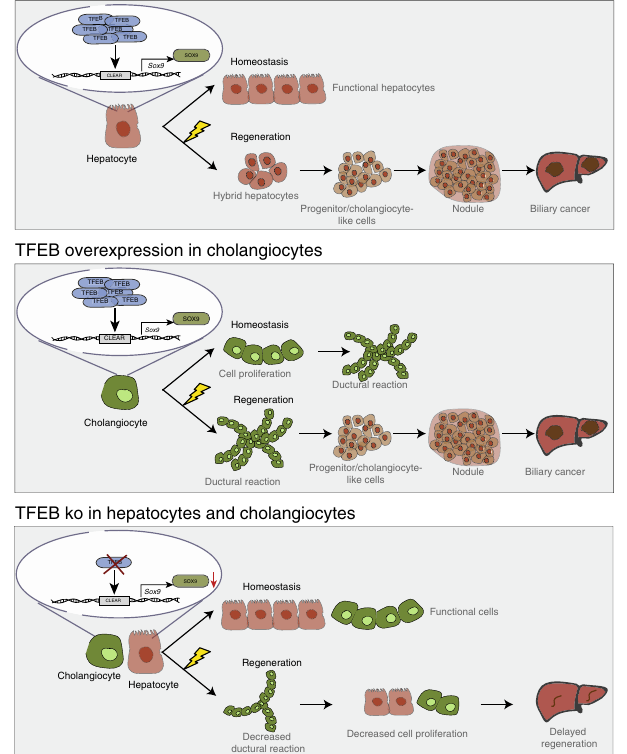
Fig. 9 Schematic representation of the effects of TFEB on liver cell differentiation in vivo. TFEB overexpression in hepatocytes does not affect hepatocyte proliferation and identity in homeostasis conditions, while it induces differentiation of hepatocytes into ductular reaction (DR)- associated cholangiocytes after injury. Conversely, TFEB overexpression in cholangiocytes induces their proliferation and DR in homeostasis and upon liver injury. On the other hand, TFEB depletion in the liver impairs normal cell regeneration after injury due to reduced induction of Sox9 expression and decreased cell